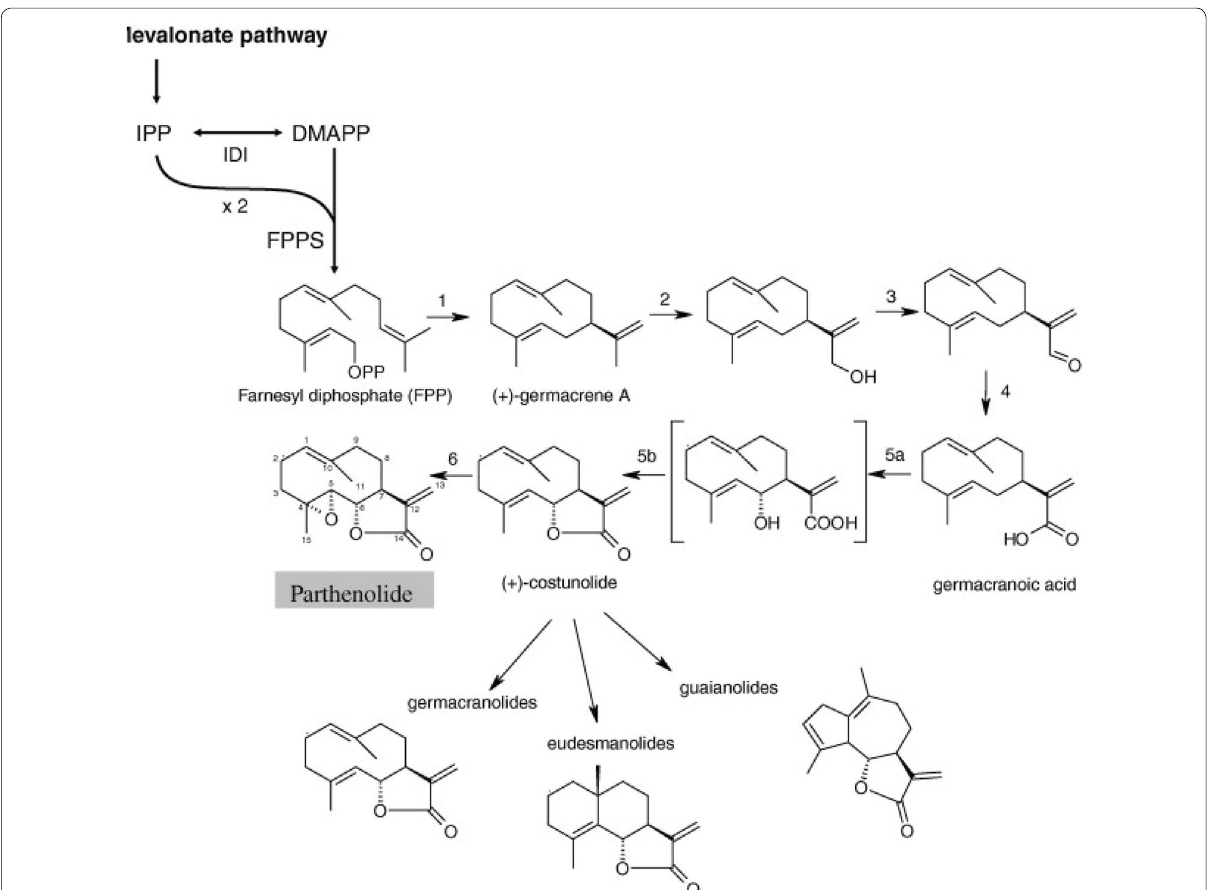
Fig. 1 Presumed biosynthetic pathway of parthenolide; step 1 is catalyzed by germacrene A synthase; steps 2, 3 and 4 are catalyzed by germacrene A oxidase; step 5a, 5b, costunolide synthase; and step 6, costunolide epoxidase/parthenolide synthase (Majdi et al.